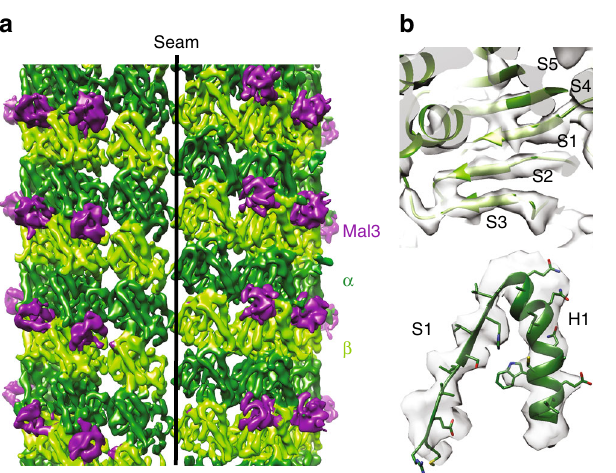
Fig. 2 Near-atomic resolution reconstruction of Mal3-bound Sp_MT. a C1 reconstruction (FSC0.5 = 9.5 Å; 0.143 = 7.5 Å) of Sp-tub GTP/Mal3-143 MTs showing the B-lattice interdimer binding sites occupied by Mal3 (purple) but missing from the A-lattice seam contacts. α -tubulin is shown in dark green and β -tubulin in light green. b Close-up portion of the central β -sheet of β -tubulin and an α -helix/sheet region of α -tubulin illustrating the quality of the symmetrized reconstruction